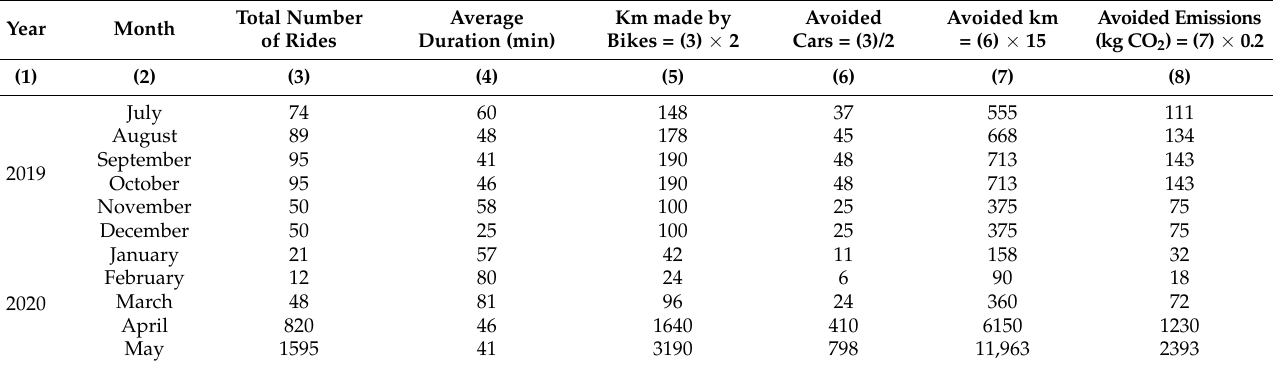
Table 6. Performance of Rhode’s BS system using the SUMPORT KPIs (own